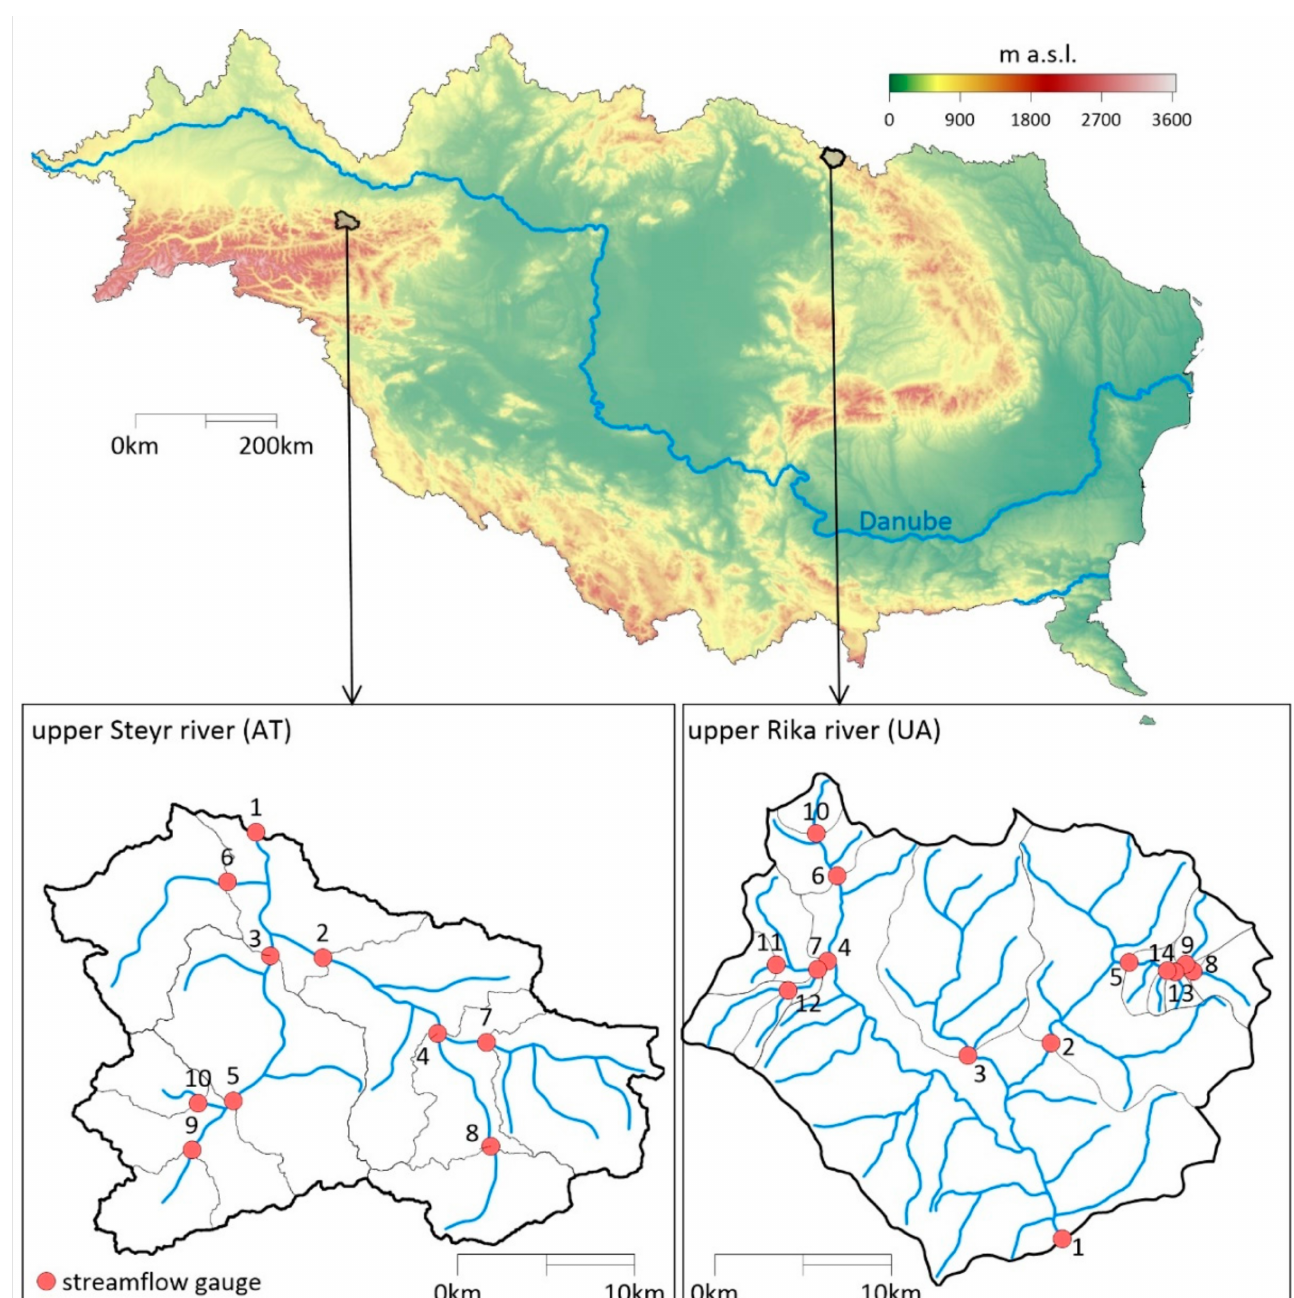
Figure 1. Location of the study catchments in the Danube River basin. The Austrian part consists of 10 catchments located in the upper Steyr basin ( bottom left panel). The 14 Ukranian catchments are situated in the Rika River basin ( bottom right panel). Labels of symbols refer to ID number in Table 1 (upper Rika River) and Table 2 (upper Steyr